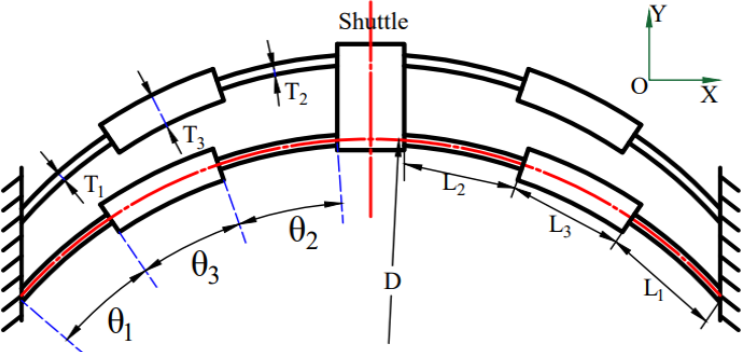
Figure 3. Fully compliant CBBM.